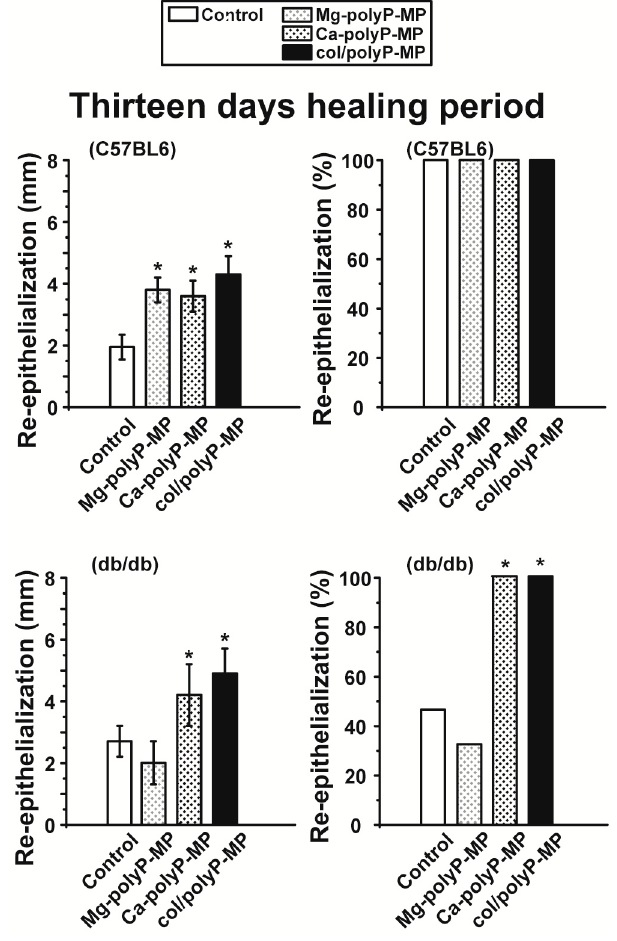
Figure 8. The effects of the tested materials on wound re-epithelialization in C57BL/6 and db/db mice on day 13. The data are presented as mean ± SEM.